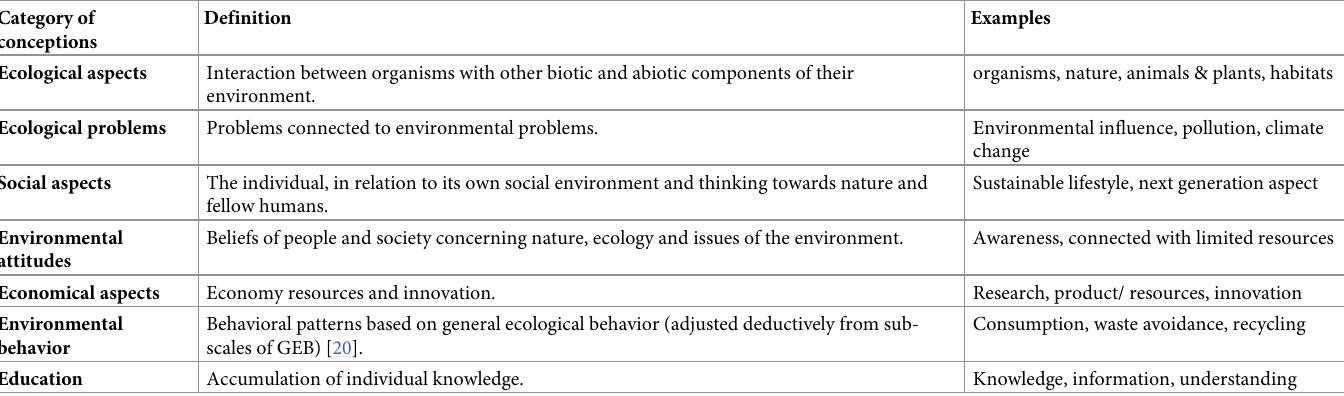
Table 2. Defined categories of freshmen´s conceptions of Education for Sustainable Development (ESD) and Environmental Education (EE).